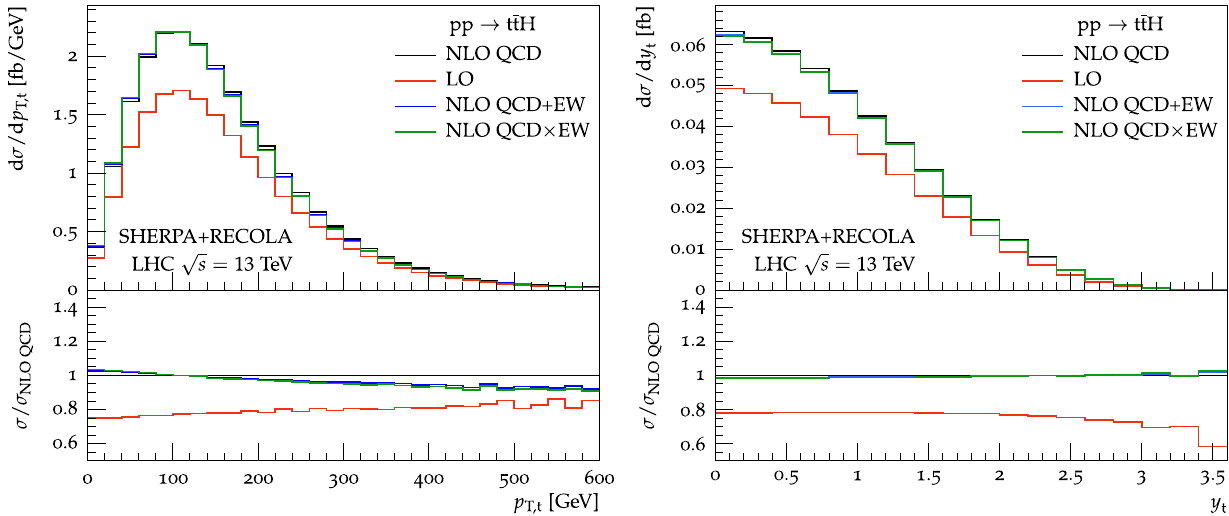
√ s = 13TeV pp → t ¯ tH at the LHC: transverse-momentum distribution ( left ) and /σ NLO /σ NLO , σ NLO and σ NLO QCD QCD + EW QCD QCD × EW